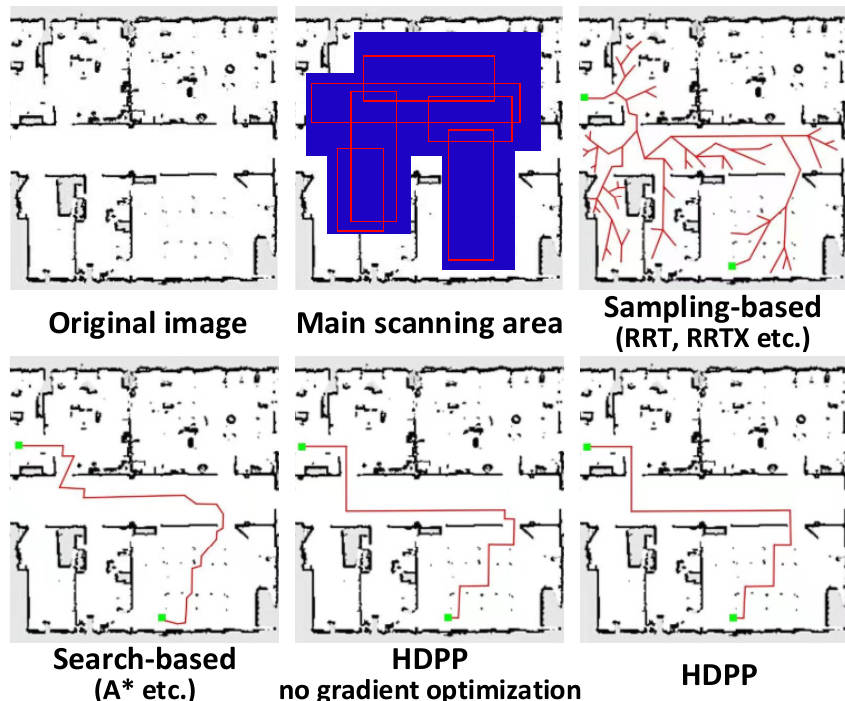
Figure 1. Illustration of an example. Boxes with red lines and blue block are main scan area. We show path planning result by HDPP (ours), sampling-based methods and search-based methods. Noticeably, the proposed HDPP has generated the least waypoints, also the most efficient in high- dimensional space. In addition, we show comparison before and after optimization in order to clearly see the effect of HDPP’s gradient optimization